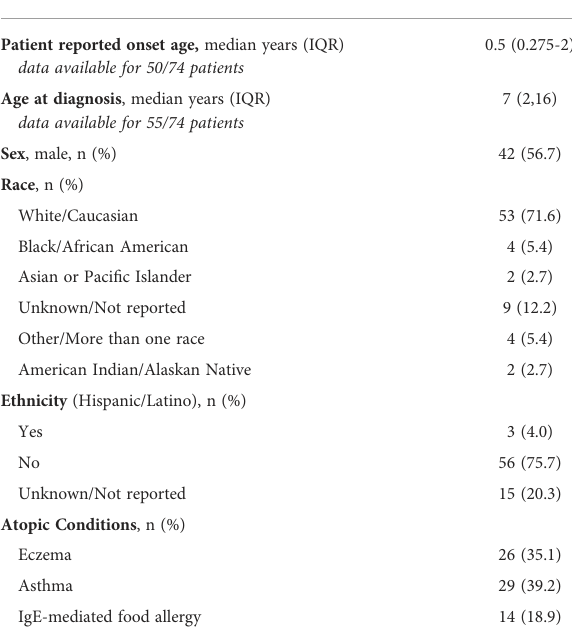
TABLE 1 Demographic and clinical characteristics of EoE and EGID patients in USIDNET (N= 74). Characteristic Value